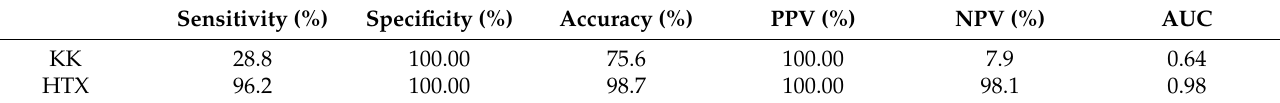
Table 2. Performance indicators for the Kato-Katz and Helmintex methods.